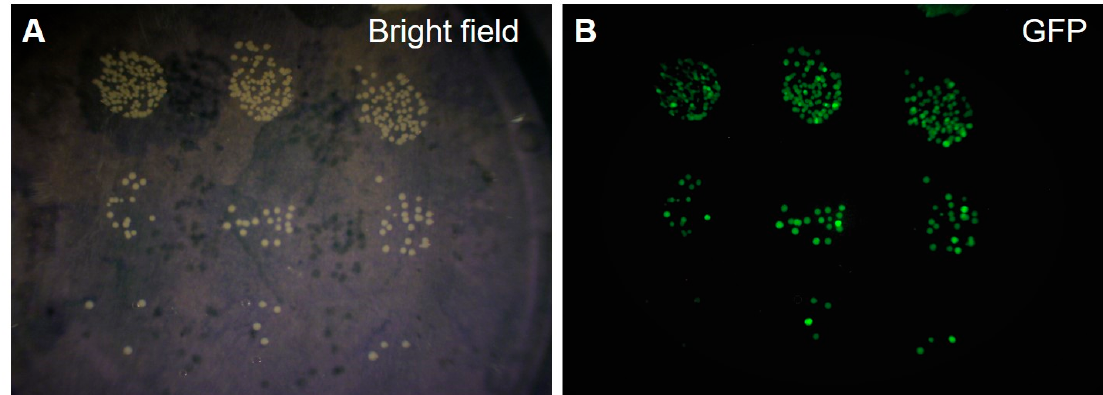
Figure 3. Agar culture from a tumor treated with S. typhimurium A1-R in a Ewing’s sarcoma PDOX model. Bright field (A) and fluorescence imaging (B) of cultured green fluorescent protein (GFP)- expressing S. typhimurium A1-R targeted to a Ewing's sarcoma PDOX tumor [28].